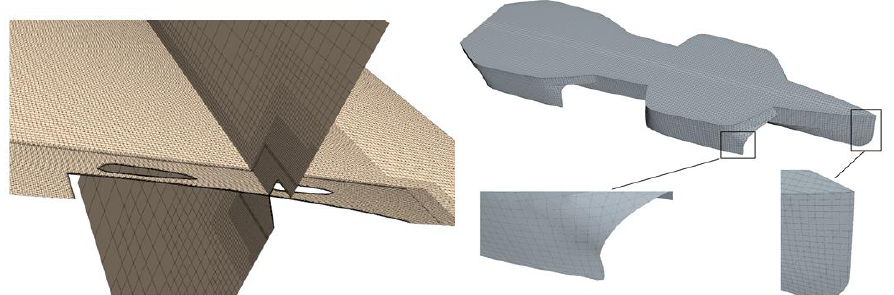
Figure 4. Mesh refinement around hull and hull.